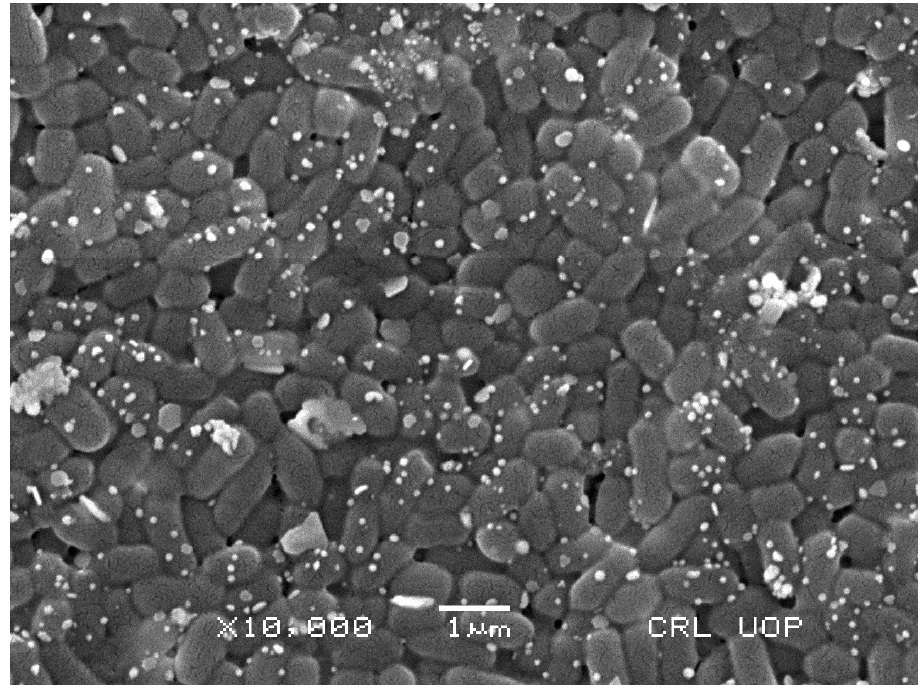
Figure 6. SEM analysis of the Carduus edelbergii mediated AuNPs.